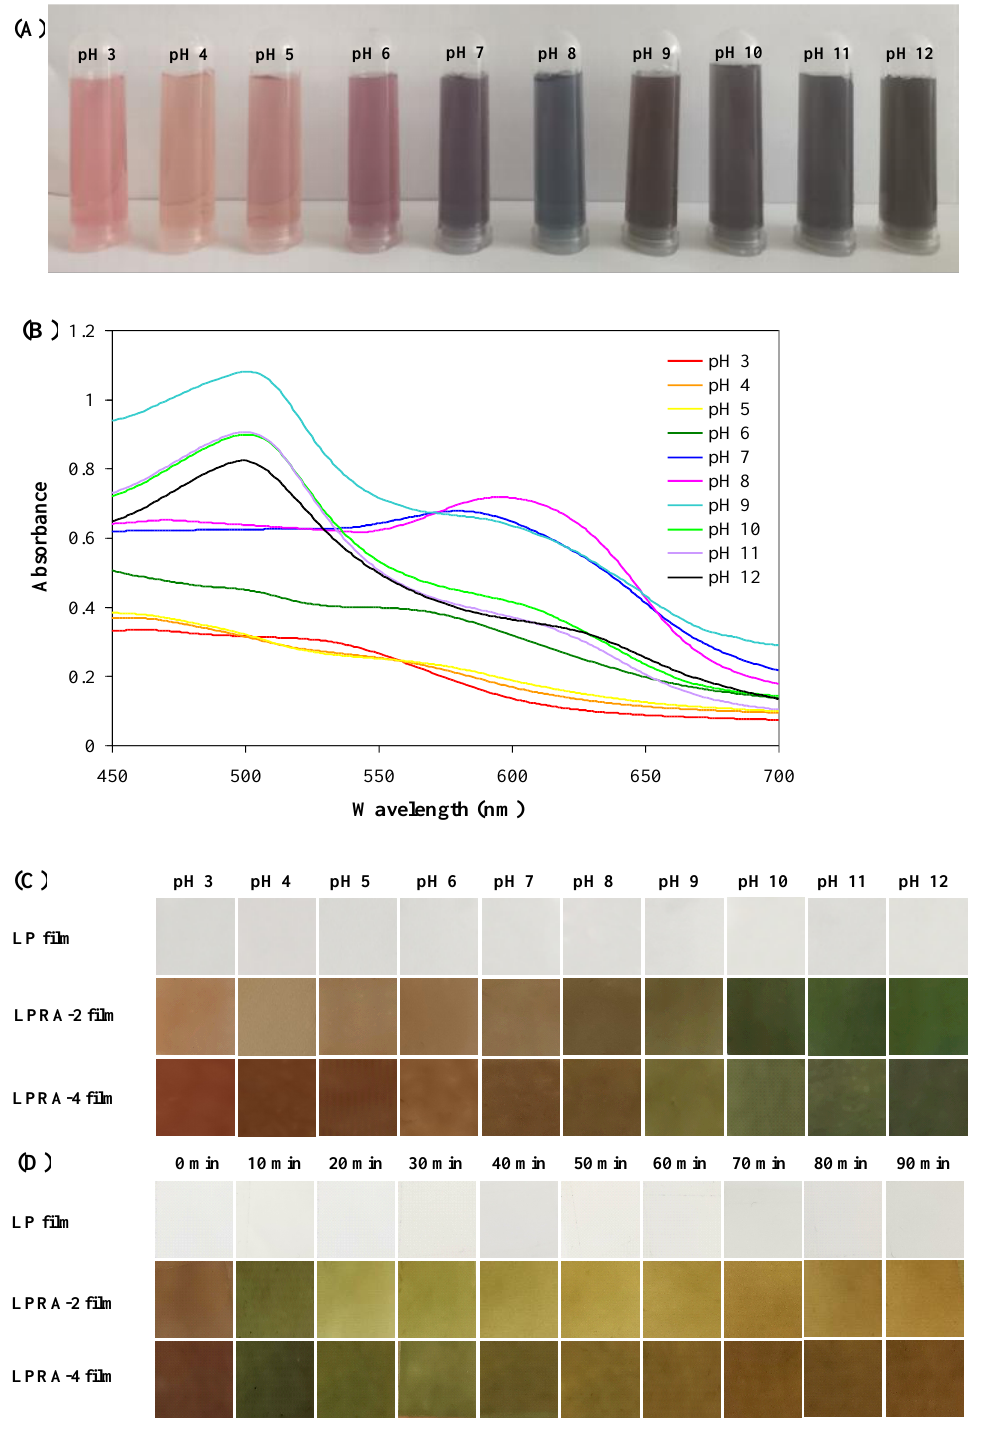
Figure 8. Color changes ( A ) and UV/Vis ( B ) spectra of RA in pH 3 – 12 buffers, and the color changes of LP film, LPRA-2 film, and LPRA-4 film in pH 3 – 12 buffers ( C ) and ammonia gas ( D ).